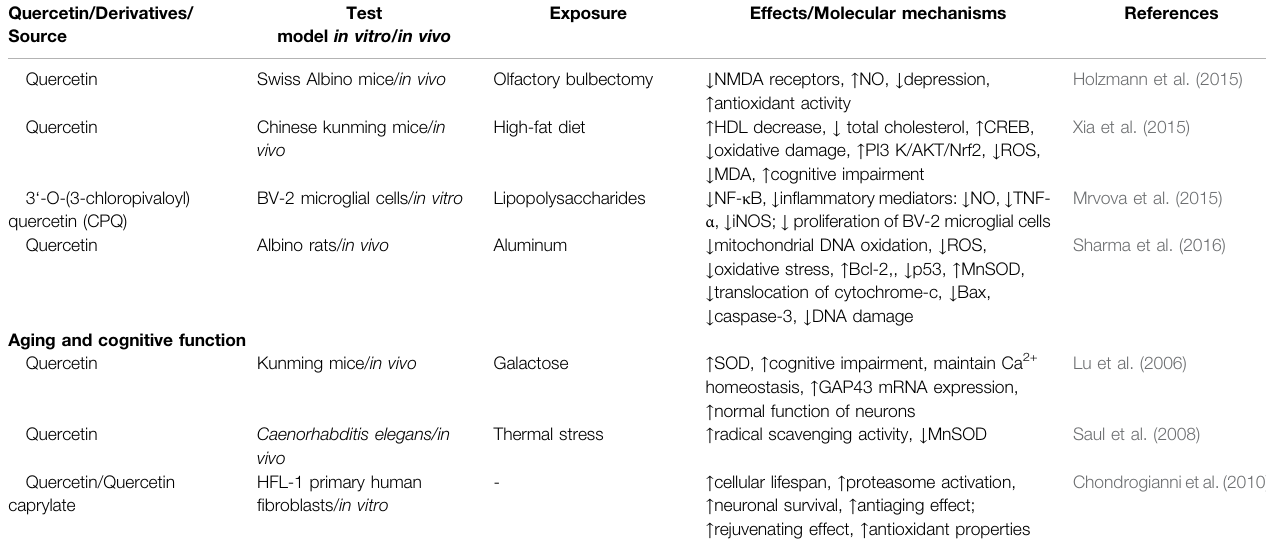
TABLE 1 | ( Continued ) Neuroprotective effects of quercetin and/or its derivatives against various neurodegenerative diseases and other brain